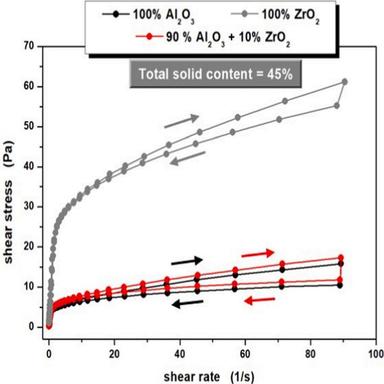
Flow curves of casting slips containing 45 vol.%of solid phase.